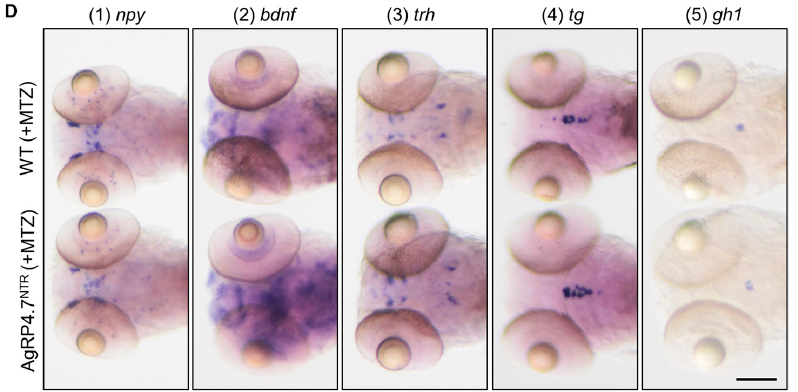
Figure 7. Effects of AgRP ablation on appetite and growth regulation in the brain of zebrafish. Real-time RT-qPCR analysis was used to measure the mRNA expression levels of ( A ) orexigenic genes ( agrp , agrp2 , npy , pdyn , pro-melanin concentrating hormone ( pmch ), hcrt , gal , and neurotensin ( nts )); ( B ) anorexigenic genes ( bdnf , sim1a , trh , tg , avp , nucleobindin 1 ( nucb1 ), corticotropin releasing hormone b ( crhb ), and oxytocin ( oxt )); and ( C ) GH/IGF axis genes ( gh1 , ghra , ghrb , igf1 , igf2b , igfbp1b , igfbp5b , igfbp6a , and igfbp6b ) in MTZ-treated WT and AgRP4.7 NTR larvae at 8 dpf, n = 30. Values are represented as the mean ± S.E.M. *** p < 0.001. ( D ) WISH experiment revealed the expression levels and patterns of npy , bdnf , trh , tg , and gh1 in the brains of MTZ-treated WT and AgRP4.7 NTR larvae at 5 dpf, n = 30. Scale bars = 100 µ m.